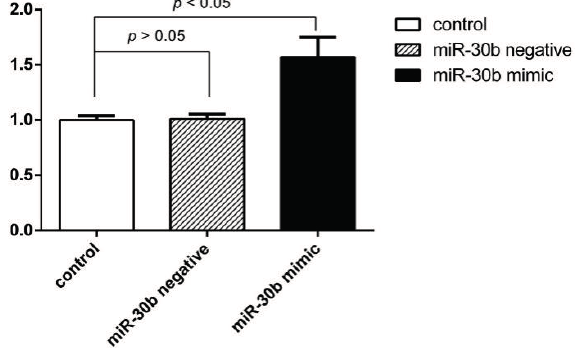
Figure 4. The expression of miR-30b upregulated after transfection of miR-30b mimic in HCAECs. The time of transfection was 24 h. Compared with the control group, the negative control group, p < 0.05 ( n = 6 in each